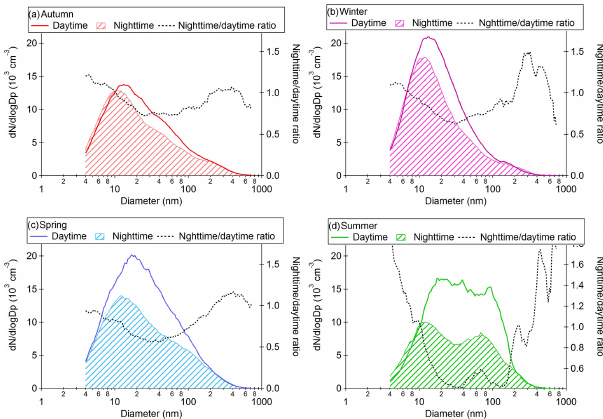
Figure 4. Median PSDs measured during the daytime (07:00– 17:00LT) and nighttime (17:00–07:00) in (a) autumn, (b) winter, (c) spring and (d)